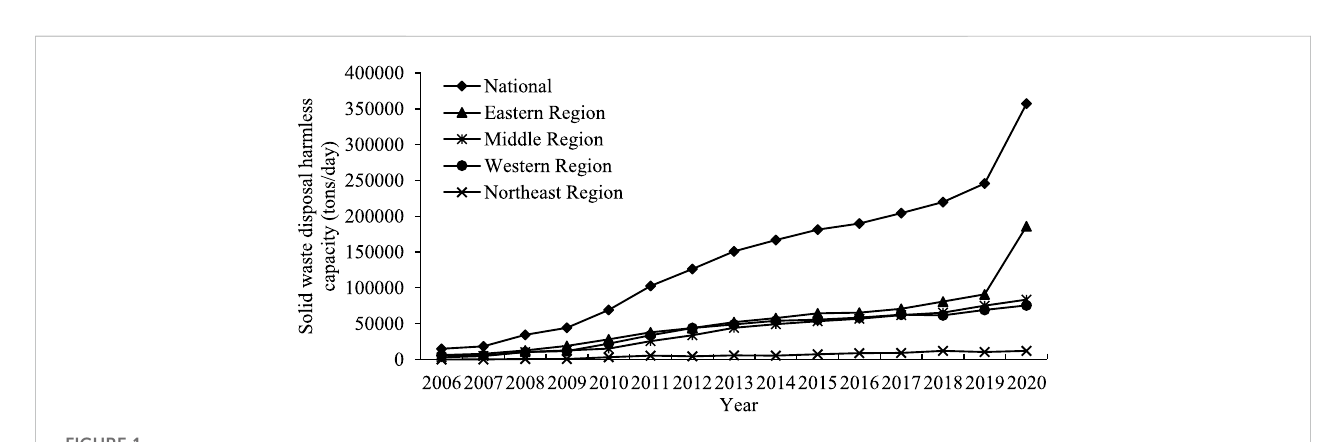
FIGURE 1 Chronological evolution of county solid waste harmless disposal capacity in China from 2006 to